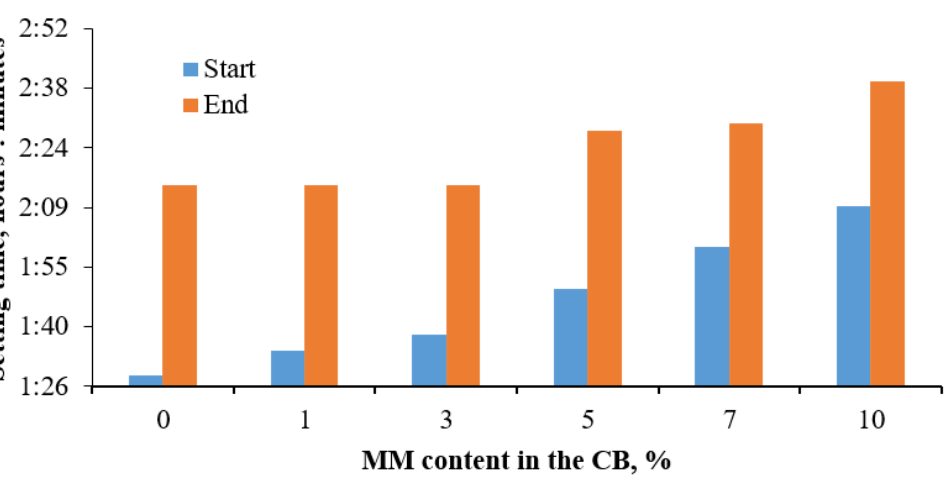
Figure 6. Dependence of the setting time of the CB-8 on the content of the MM1-500. For 3D printing, this will have a positive effect, since it will help to eliminate cracking during hydration. The results show that the start of setting is 1 h and 56 min and the end of setting is 2 h and 45 min. The end of the setting of the composite binder is associated with the addition of the mineral modifier, which reduces the setting time of the binder and improves its performances. SEM images of the composite binder confirm the consolidation of cement paste (Figure 7). This fact, of course, affects the strength indicators in the direction of their increase.